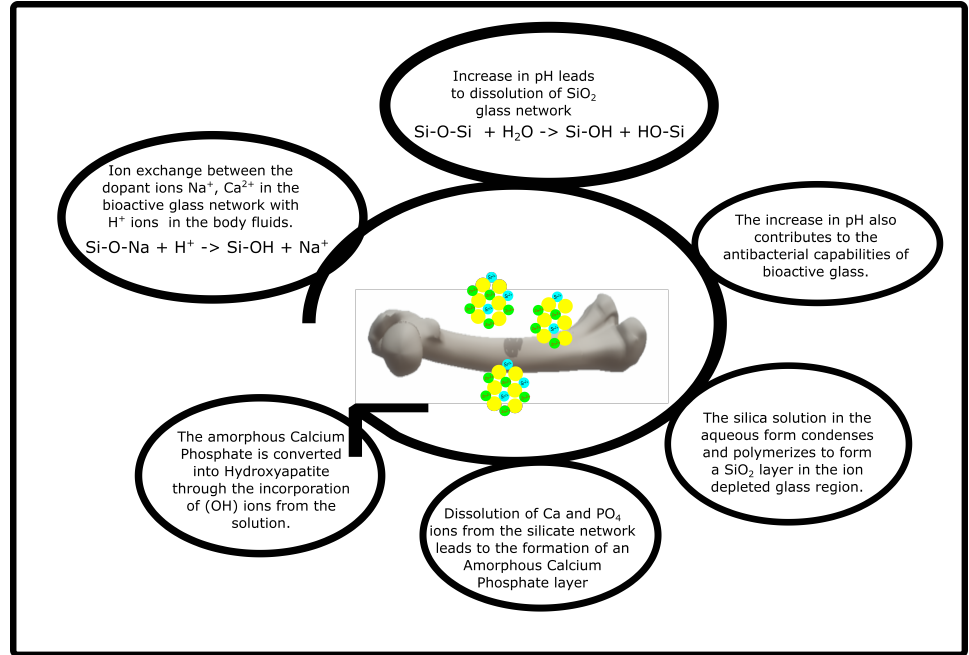
Figure 1. Schematic of the apatite formation mechanism in bioactive glass scaffolds.